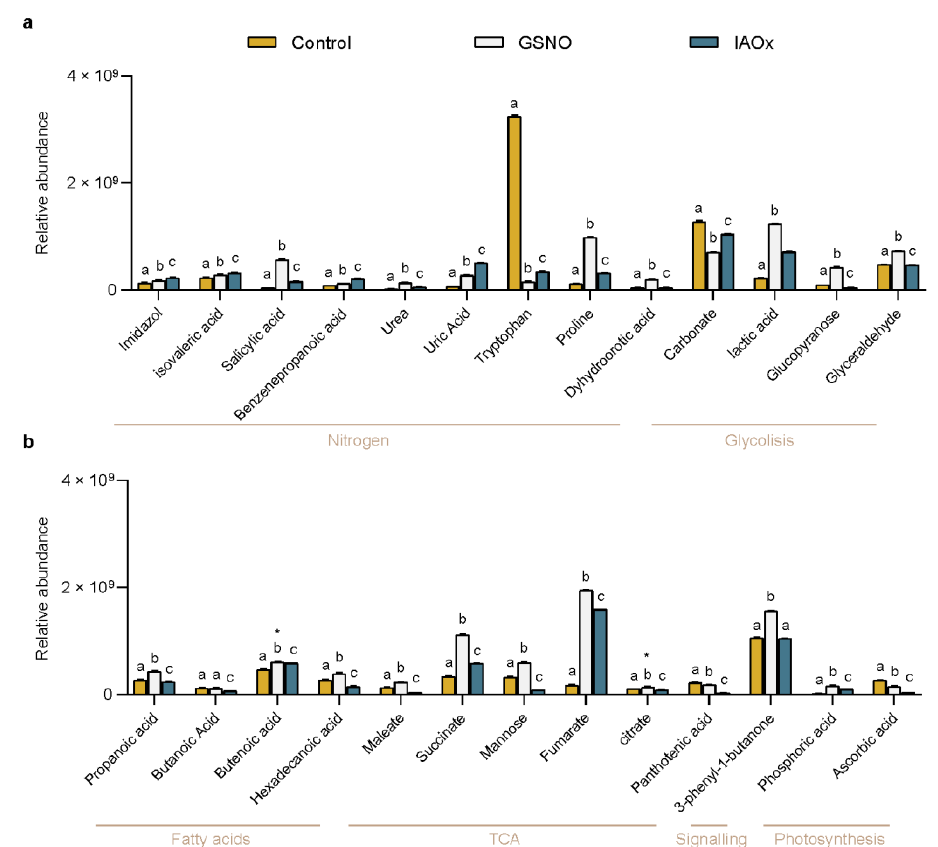
Figure 2. The relative abundance of ( a ) Nitrogen- and Glycolysis -tagged molecules and ( b ) Fatty acids , TCA (Tricarboxylic Acid Cycle) , Signaling, and Photosynthesis -tagged molecules identified in A. thaliana cells exposed for to 2 h to GSNO (light grey) or IAOx (blue) or no-treated cells (yellow). Molecules are sorted by their labeling. Letters denote the statistical differences ( p < 0.001, * p < 0.05) between treatments within each molecule in a two-way ANOVA Tukey post-hoc analysis.